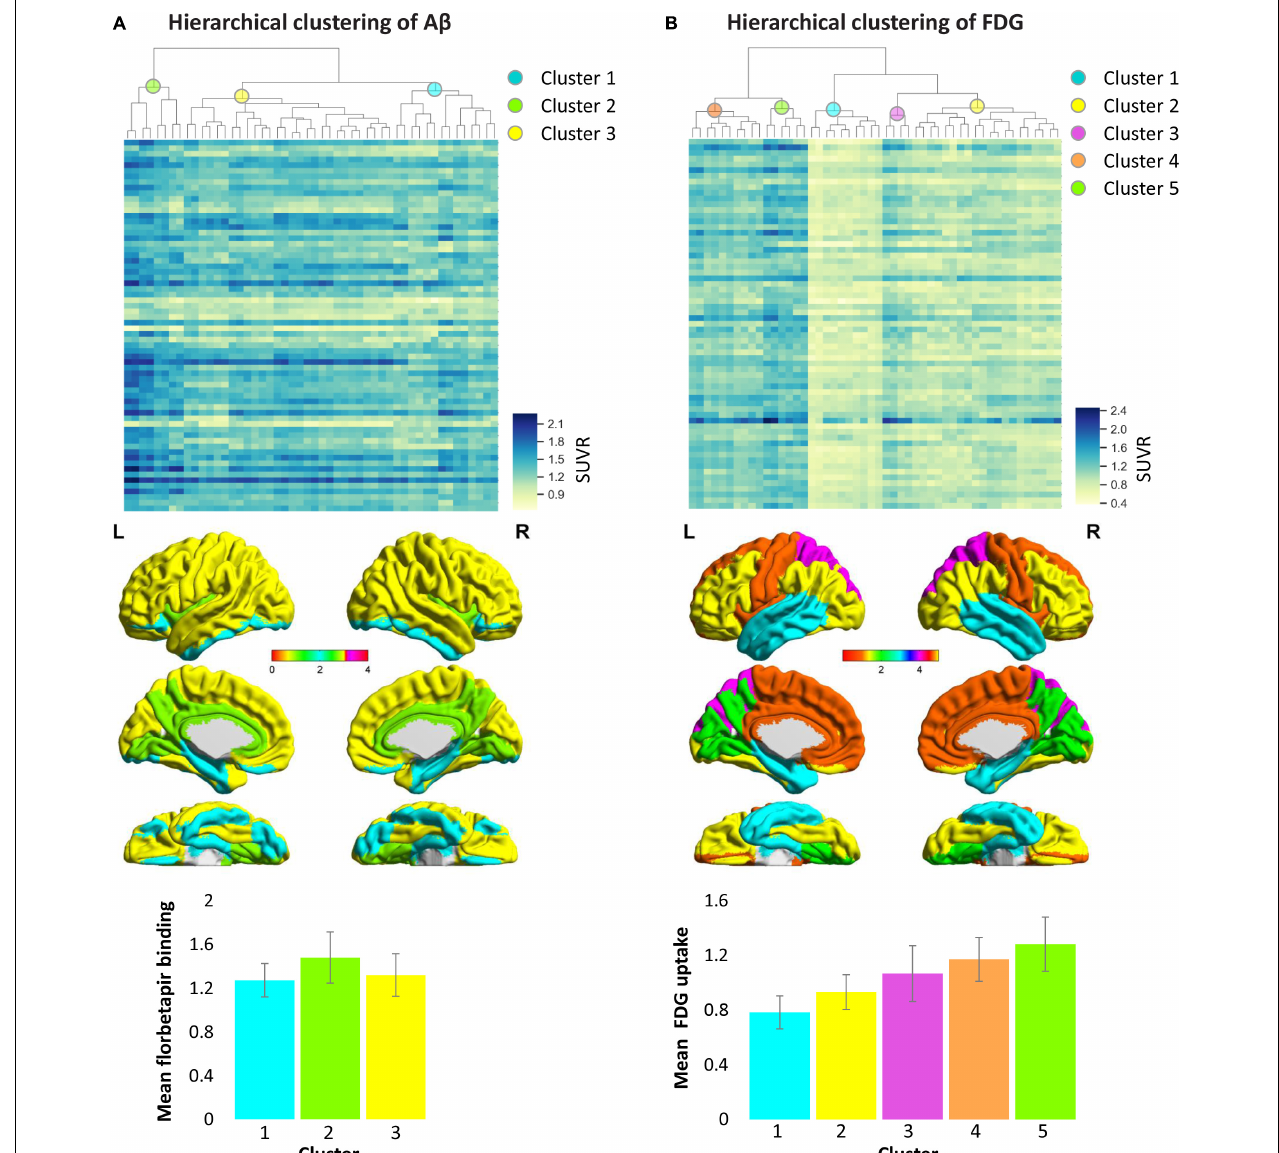
FIGURE 4 | Hierarchical clustering of cortical A β deposition (A) and glucose metabolism (B) patterns in AD patients. Columns of heat maps correspond to the A β and FDG values of each cortical area, and rows correspond to samples. Color bars marked on the right indicates SUVR value, blue, highest; yellow, lowest. The dendrograms on the top show the classification results, which indicate the three categories from A β data and five categories from FDG data represented by the different colored spheres. The bar chart below shows the average SUVR values of each category in patients with Alzheimer’s disease. The colors in the bar chart correspond to categories in the brain maps. AD, Alzheimer’s disease; FDG, fluorodeoxyglucose; SUVR, standardized uptake value